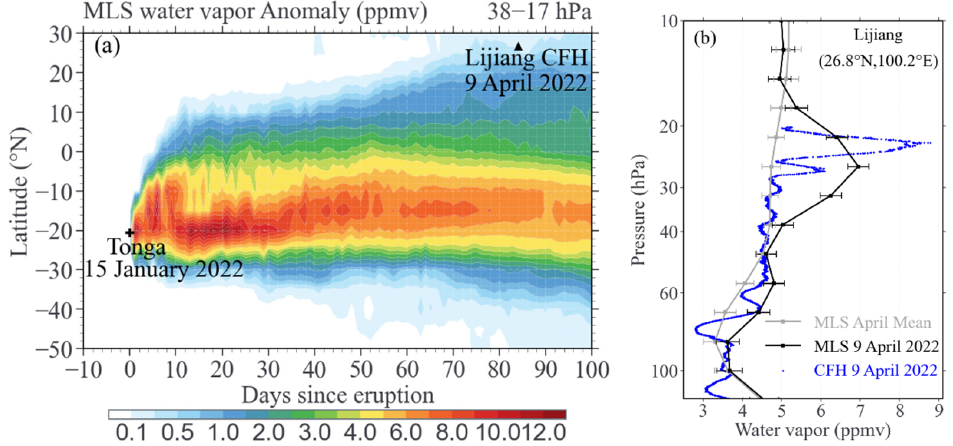
Figure 3. ( a ) Zonal mean water vapor anomalies (ppmv) as a function of latitude and time over 38–17 hPa levels. The locations of Tonga volcano and Lijiang are marked with a black plus sign and a triangle, respectively. ( b ) Vertical profiles of water vapor at Lijiang on 9 April 2022, derived from in situ observation (blue), and MLS remote sensing observation (black). The gray line shows the mean April water vapor with standard deviations derived from MLS during 2005–2020.